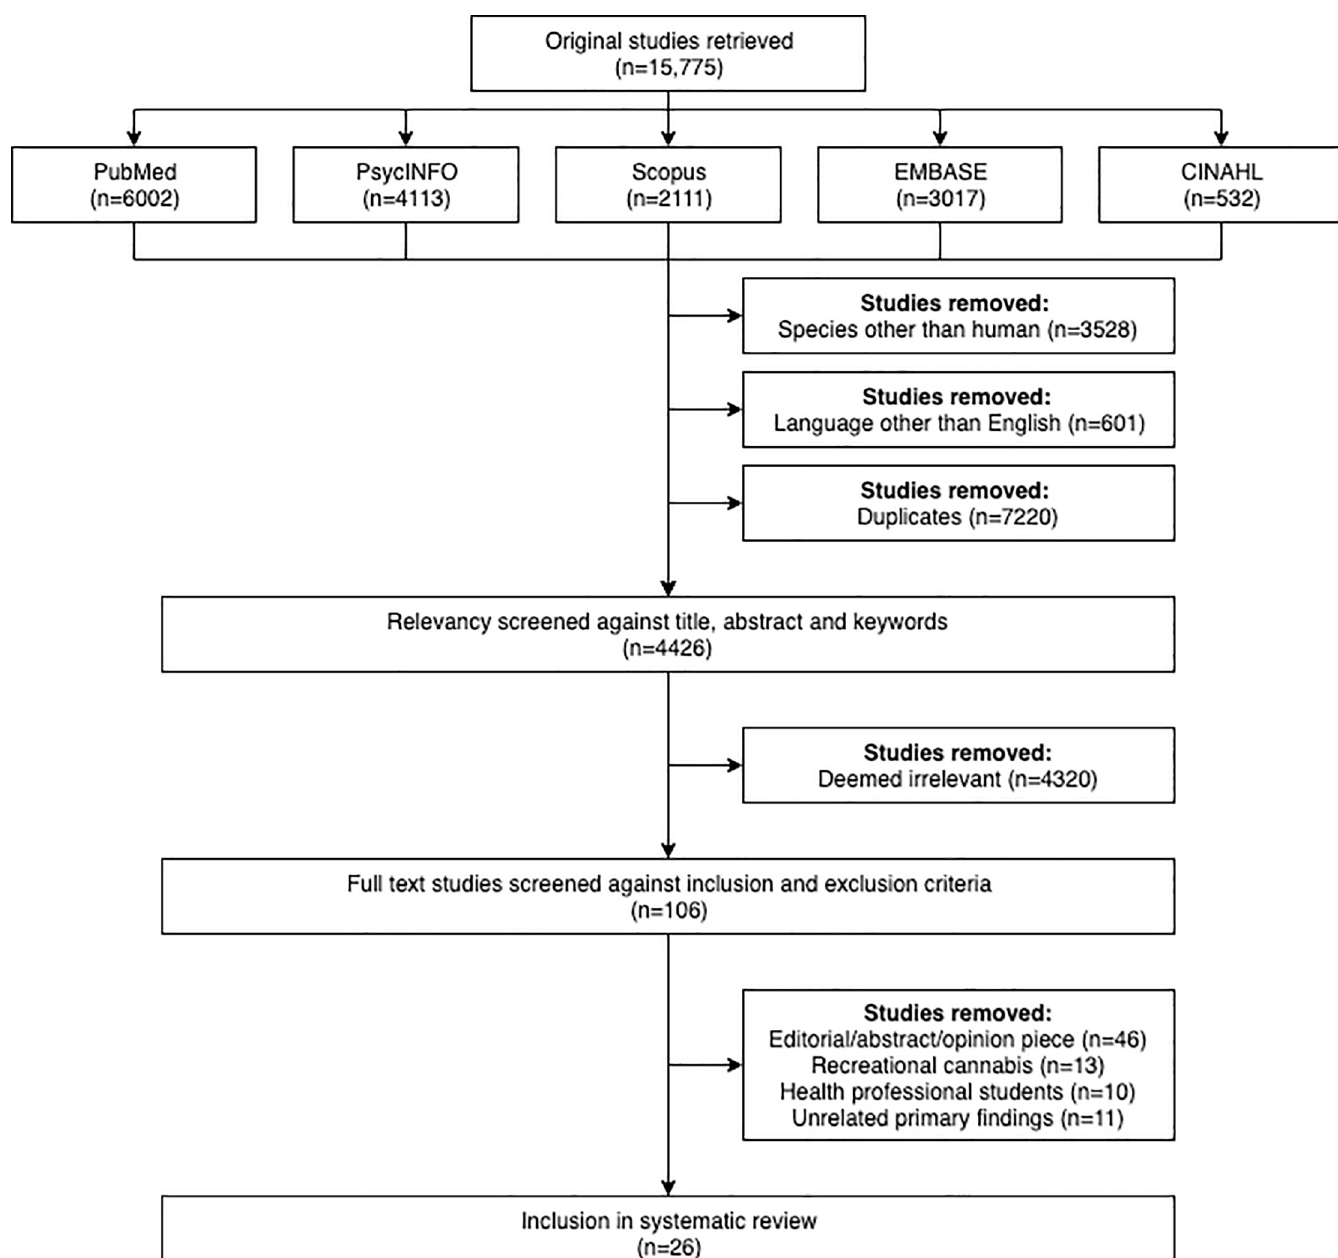
Fig 1. PRISMA flow diagram of included